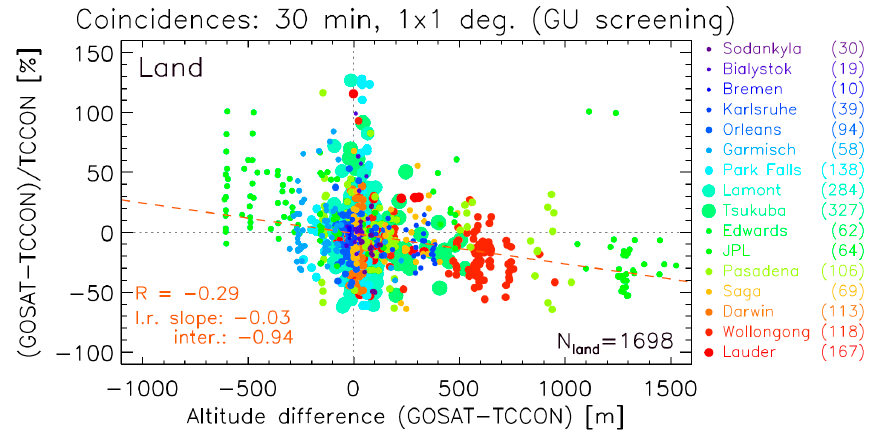
Figure 9. Relative differences (GOSAT-TCCON)/TCCON as a function of the difference, in meters, between the retrieved altitude of the GOSAT footprints and the altitude of the TCCON sites, for GOSAT land scans only. The caption and color-coding are identical to those of Figure 3.